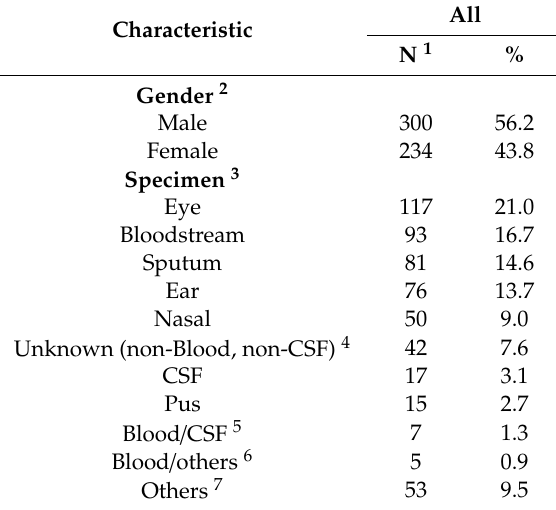
Table 1. Characteristics of the study population and unique Streptococcus pneumoniae isolates that were detected at Jordan University Hospital during 2000–2018. All Characteristic N 1